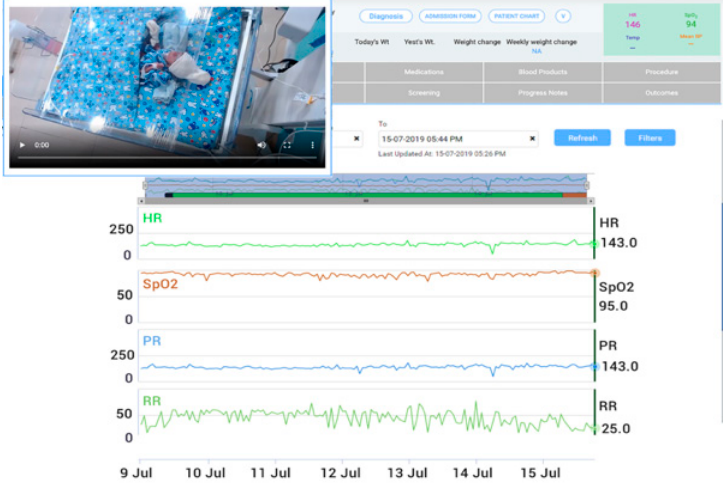
Figure A6. Bedside interface to display manipulation video and physiological